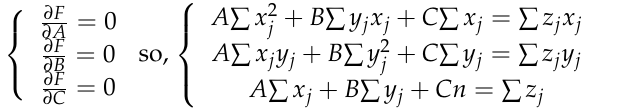
Figure 2. Schematic of the lunar rover’s current region R cur .